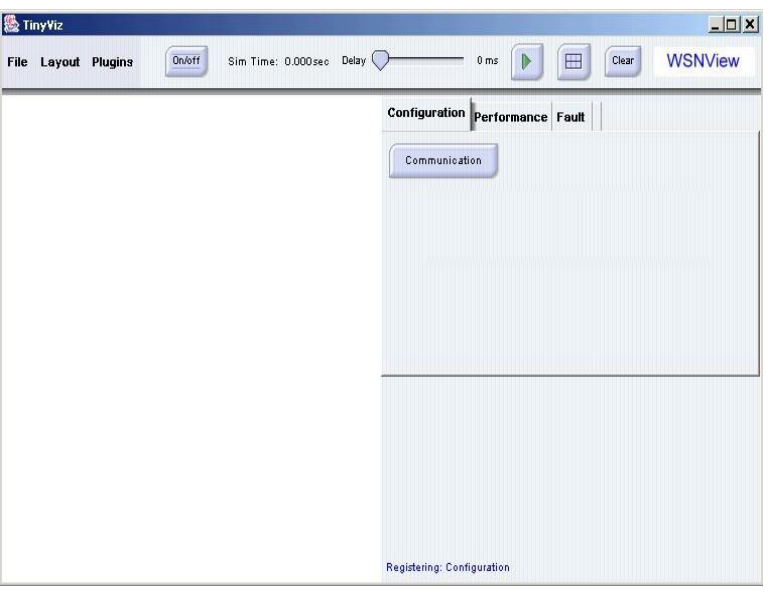
Figure 4. WSNManagement User